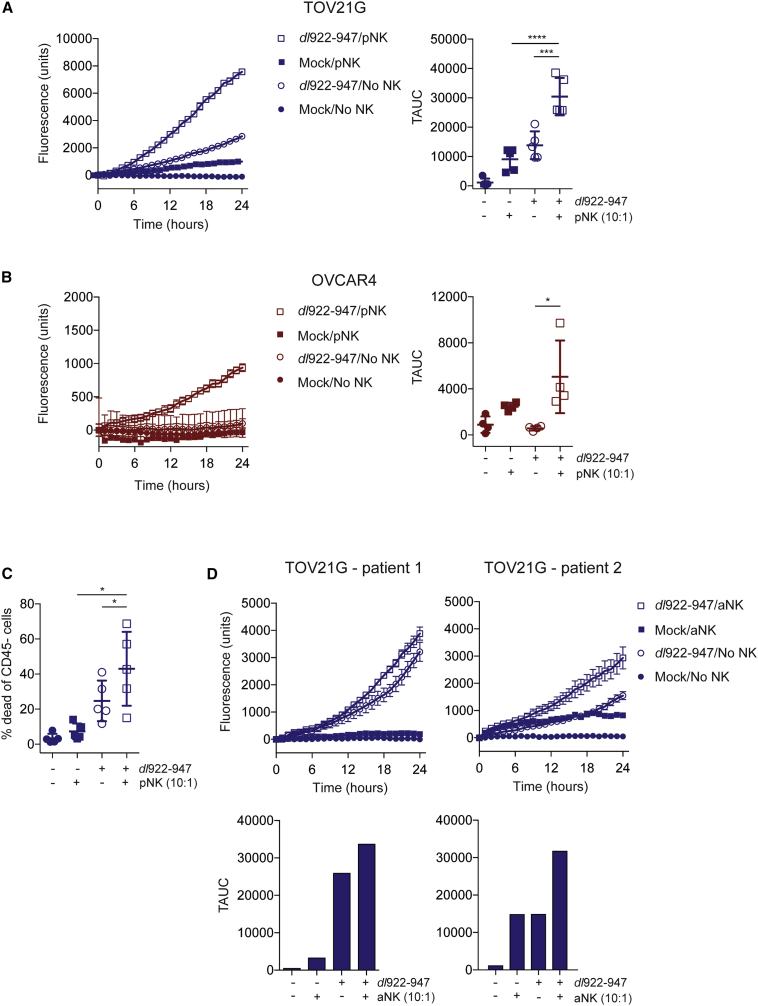
Peripheral Blood and Ascites NK Cells Increase the Cytotoxicity of Oncolytic AdenovirusCytotoxicity of peripheral blood NK cells (pNK) or NK cells isolated from ovarian cancer ascites (aNK) against TOV21G and OVCAR4 infected with dl922-947 (MOI 10, 48 h) or enadenotucirev (MOI 100, 48 h) was assessed by time-lapse microscopy in (A), (B), and (D). Cytotoxicity of pNK against (A) TOV21G (n = 5) and (B) OVCAR4 (n = 4). Fluorescent counts over time from individual experiments (left) and summary data (right) are presented. (C) Cytotoxicity of pNK against TOV21G (n = 5) by flow cytometry. Data represent the percentage of dead CD45− cells (TOV21G). (D) Cytotoxicity of aNK from patient 1 and patient 2 against TOV21G (one-way ANOVA with multiple comparisons test; error bars are not plotted when they are smaller than the symbol size).